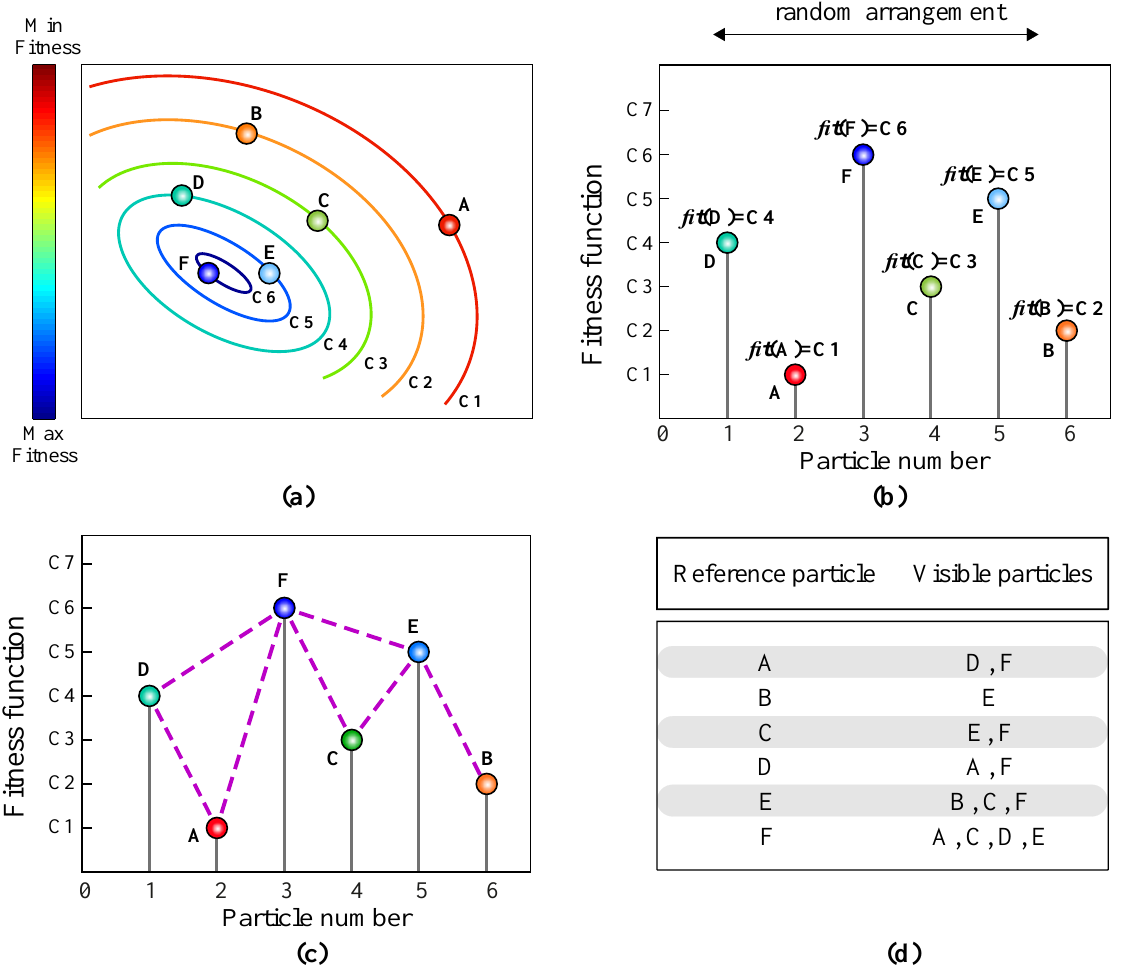
Figure 2. A simple example of the visibility criterion assessment in the VPSS algorithm: ( a ) the population of candidate solutions in the search space; ( b ) converting the population into a particle series representation; ( c ) the corresponding visibility graph for the particle series; ( d ) visible particles associated with each reference particle.